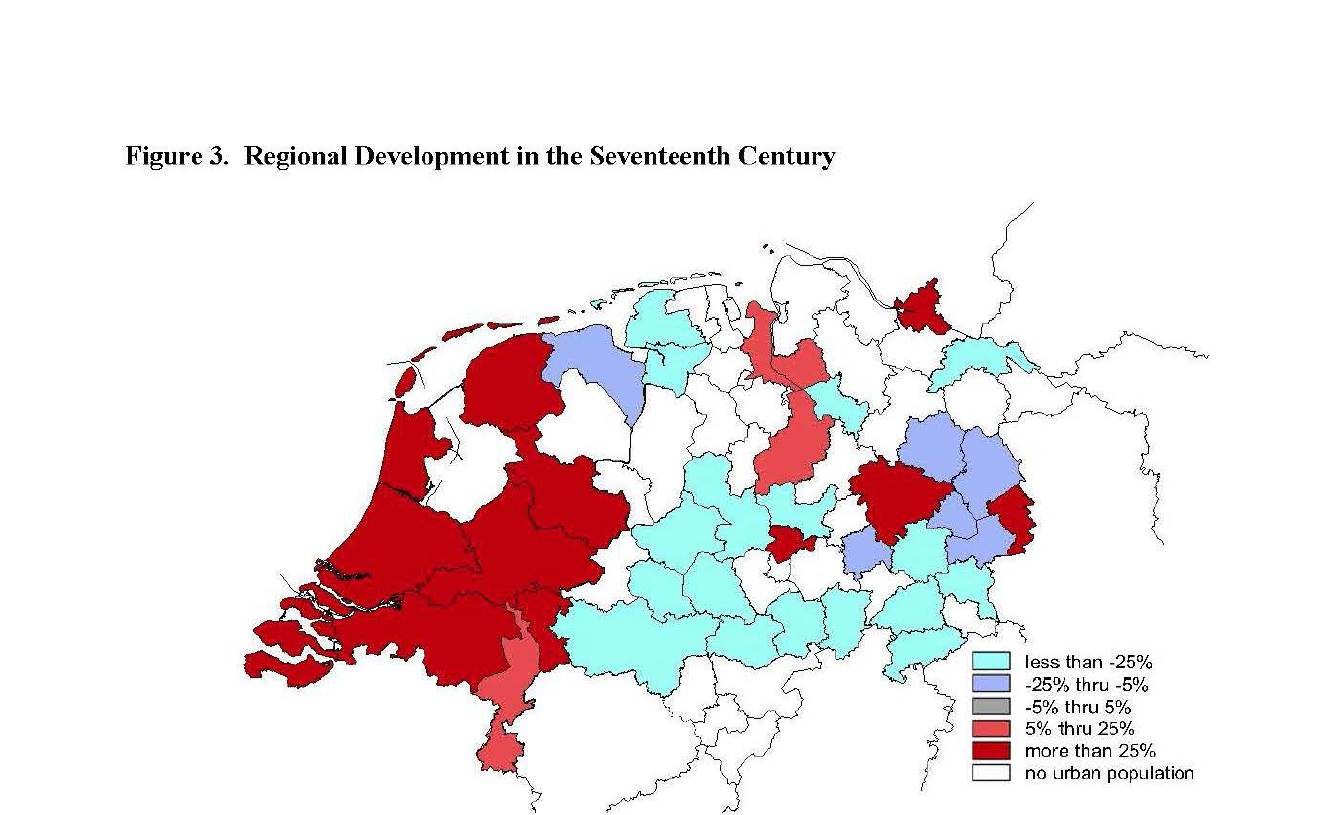
Figure 3. Regional Development in the Seventeenth